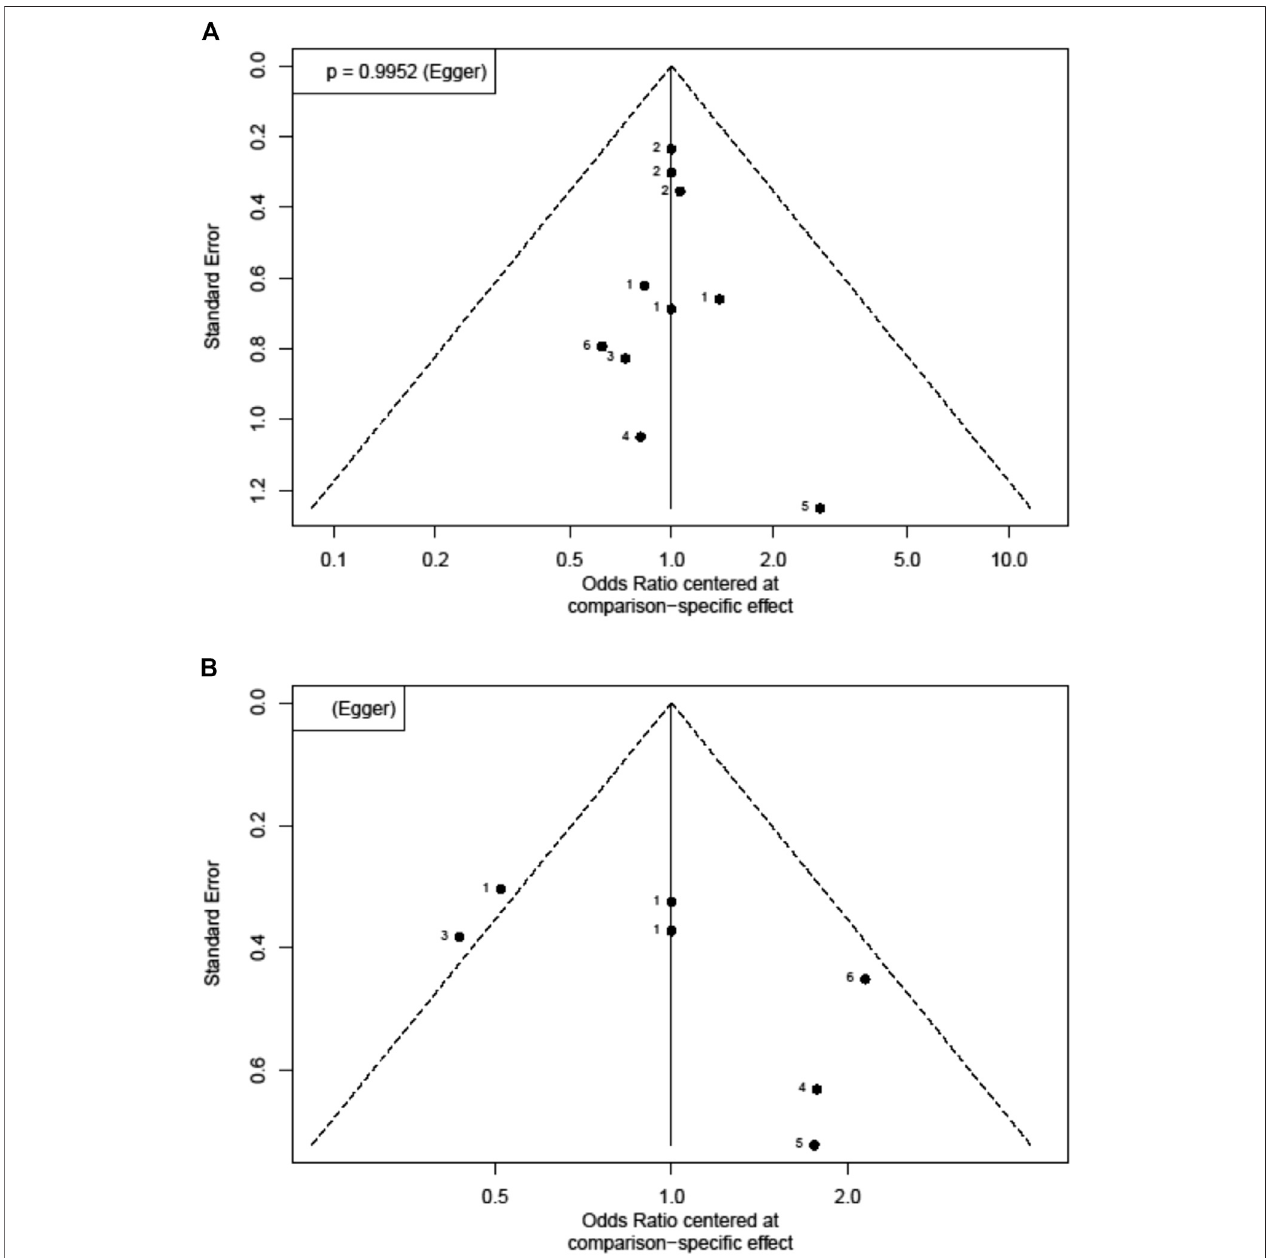
FIGURE 4 | Funnel plots for each outcome. Each dot re fl ects a study; the y -axis re fl ects the sample size or standard error, and the x -axis re fl ects the effect size of eachstudy.Largestudiesaredistributedinthetopoftheplot,andsmallerstudiesarescatteredtowardthebottomoftheplot (A) riskofcoronaryarterylesions(CAL) (B) risk of intravenous immunoglobulin (IVIG) resistance (C) length of hospital stays.